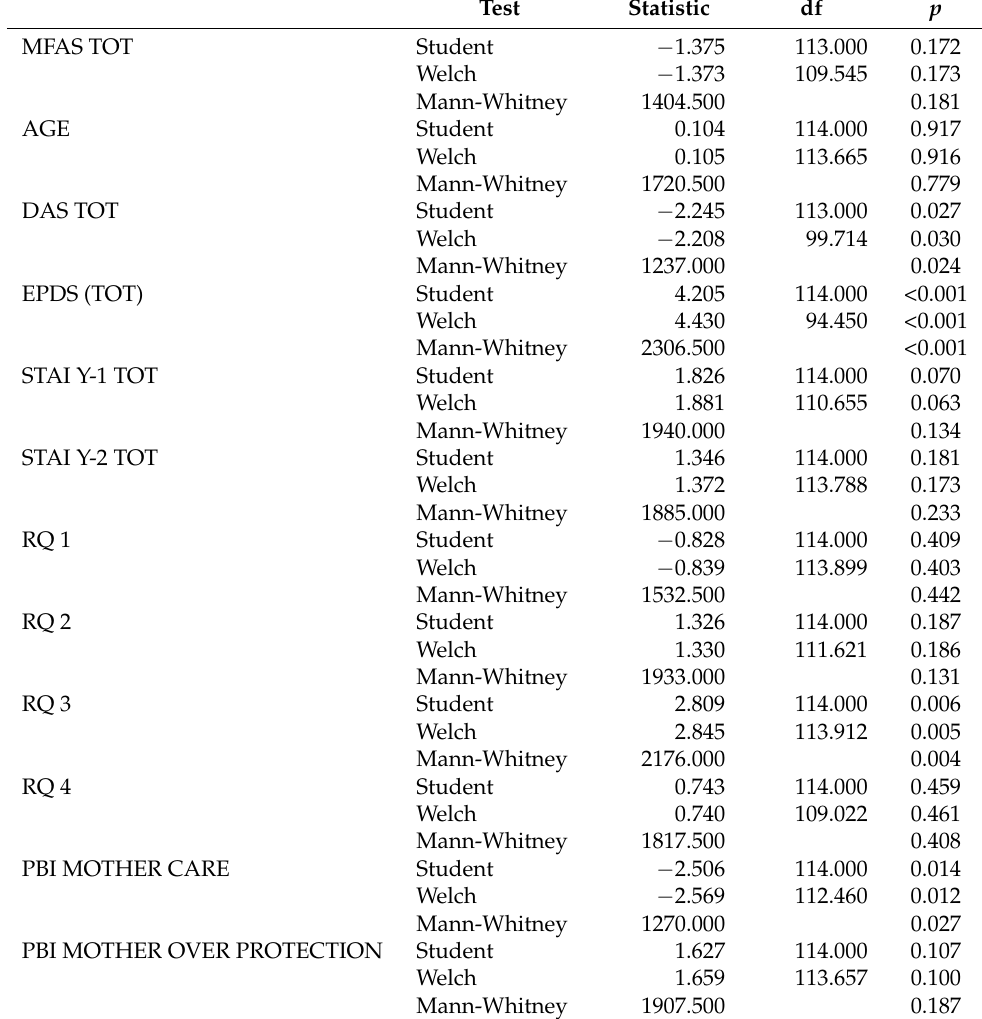
Table 7. Independent samples t-test—continuous variables versus breastfeeding six months after partum